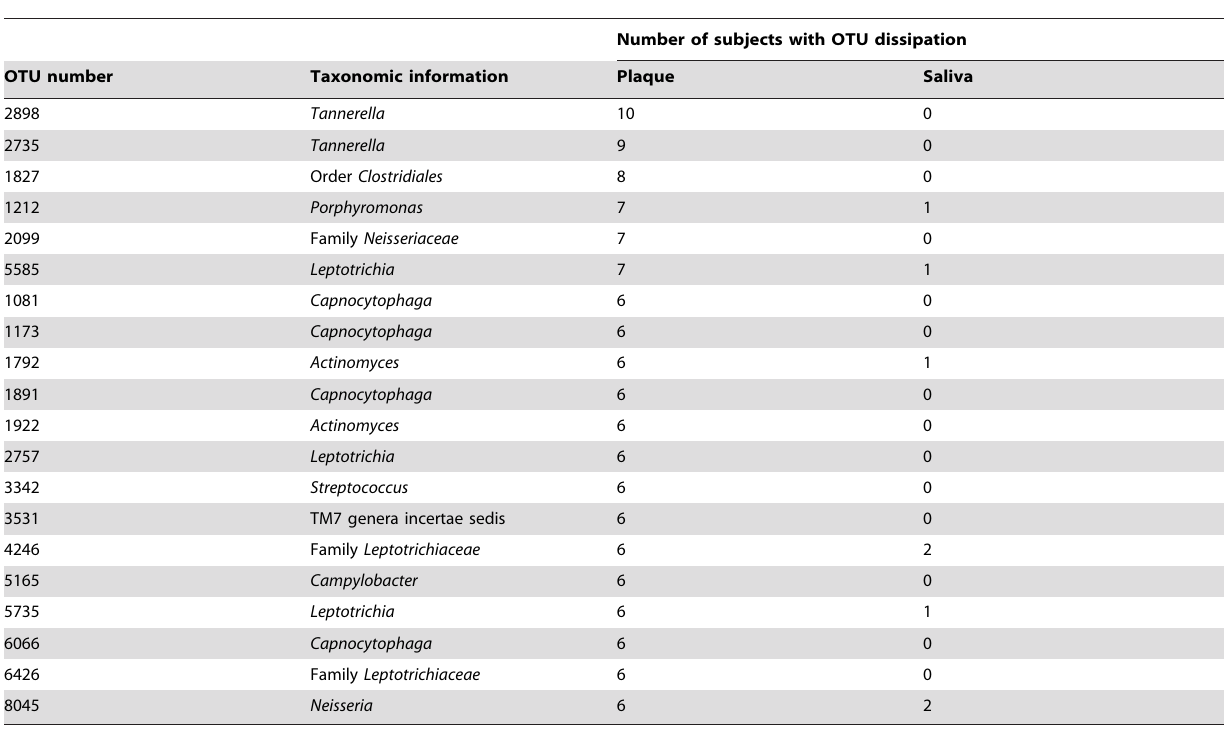
Table 5. Taxonomic information for the operational taxonomic units (OTUs) that disappeared from supragingival plaque microbiota after periodontal